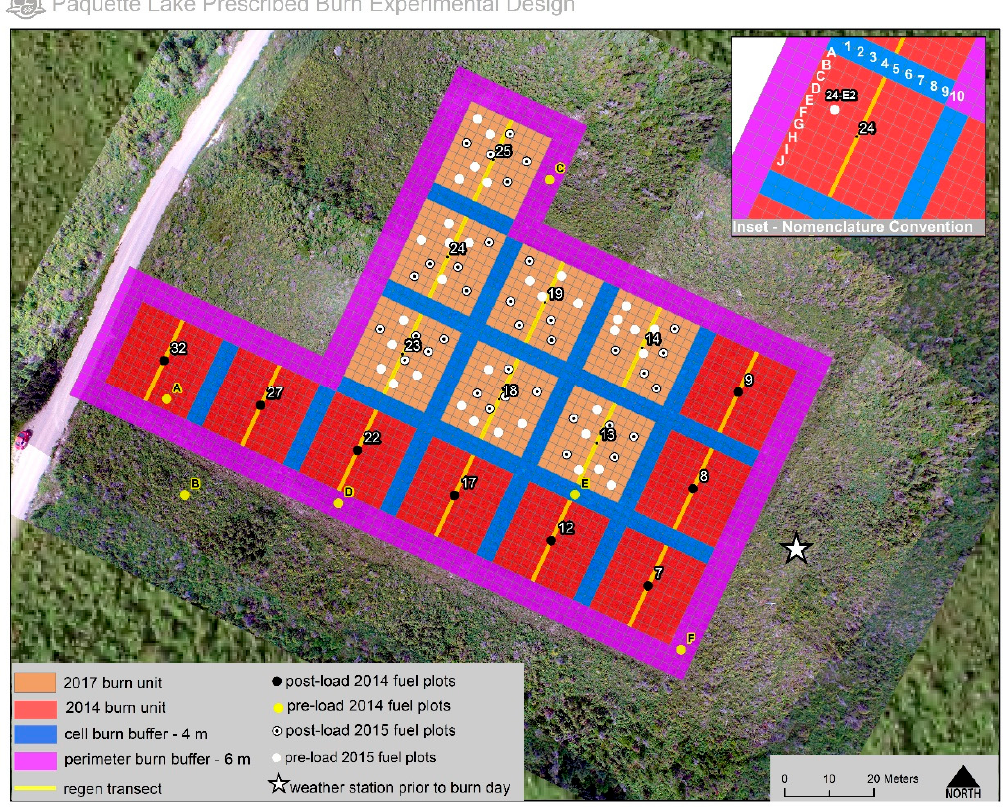
Figure 2. Burn unit layout and location of fuel loading sampling plots at the Paquette Lake Prescribed Fire Site in Cape Breton Highlands National Park.